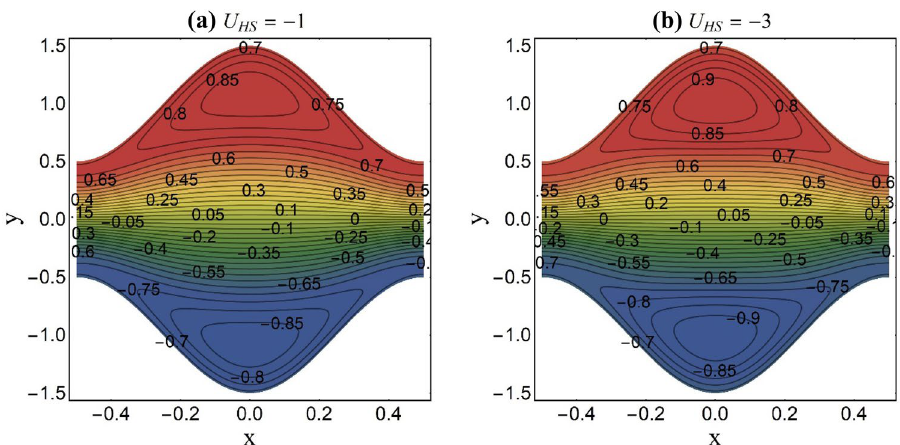
Figure 12. Streamlines pattern at fixed K = 2 and Ha =